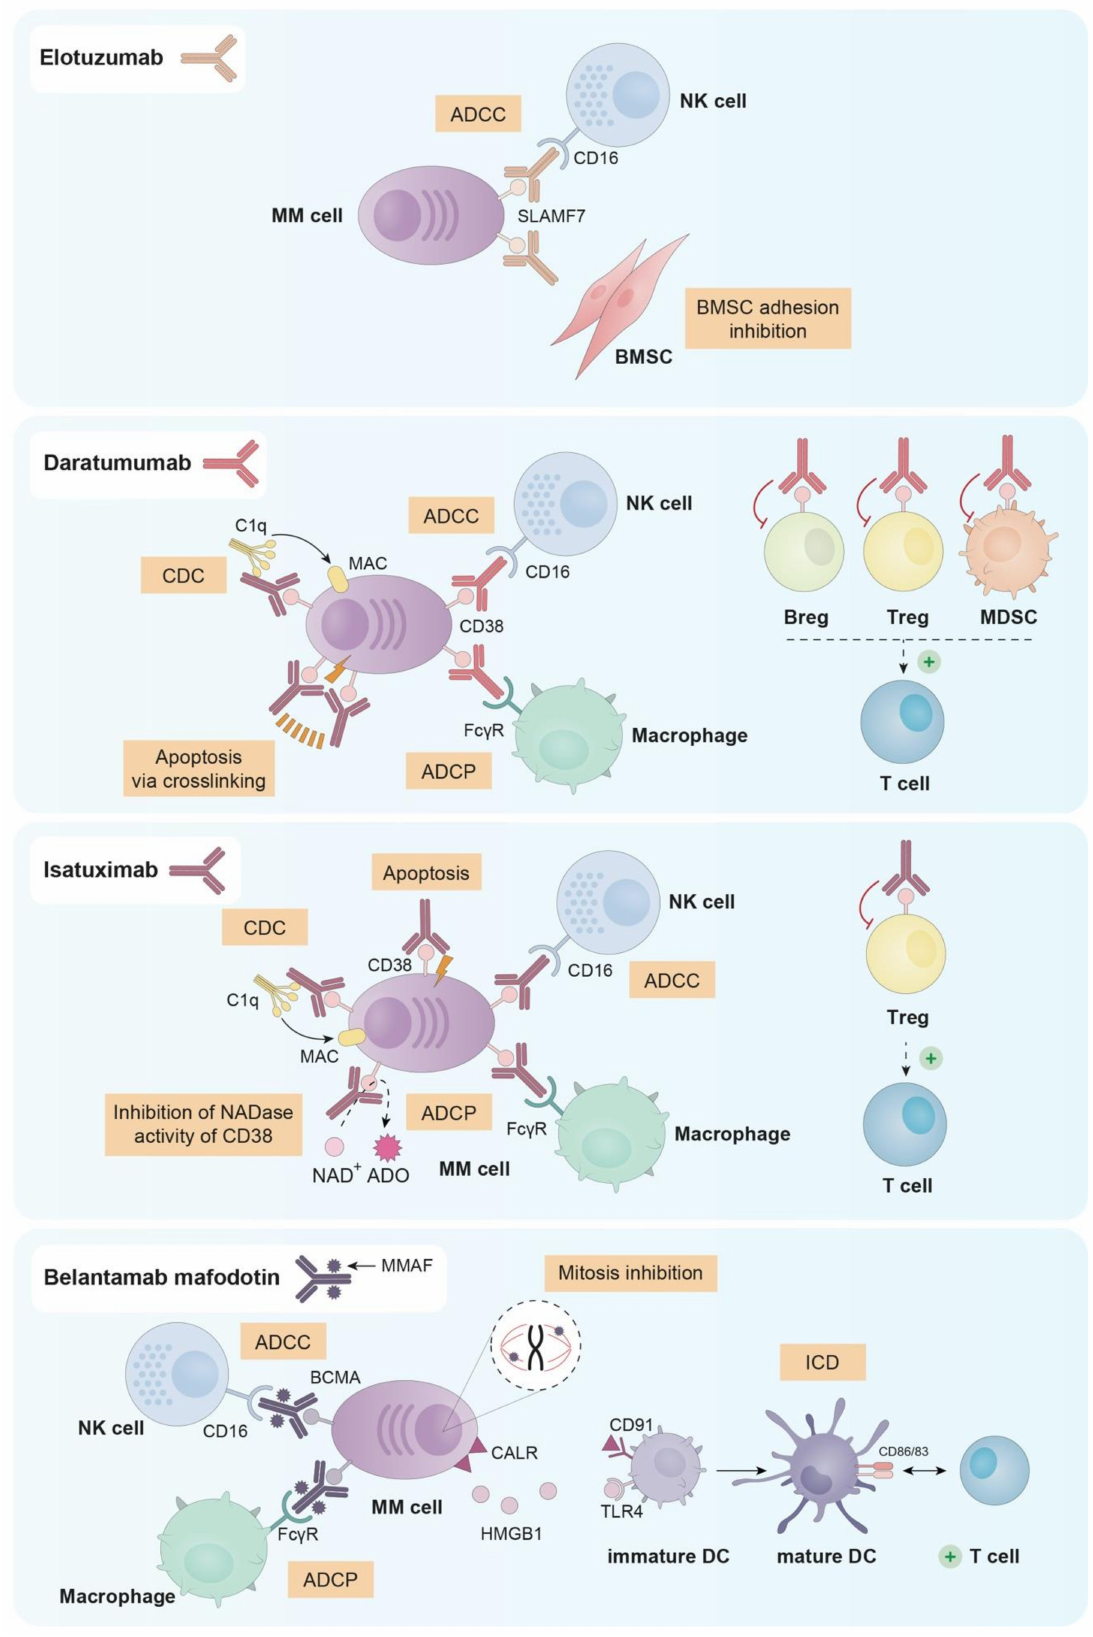
Figure 2. Principal mechanisms of action of the three naked mAbs (elotuzumab, daratumumab and isatuximab) and the ADC (belantamab mafodotin) approved for the treatment of